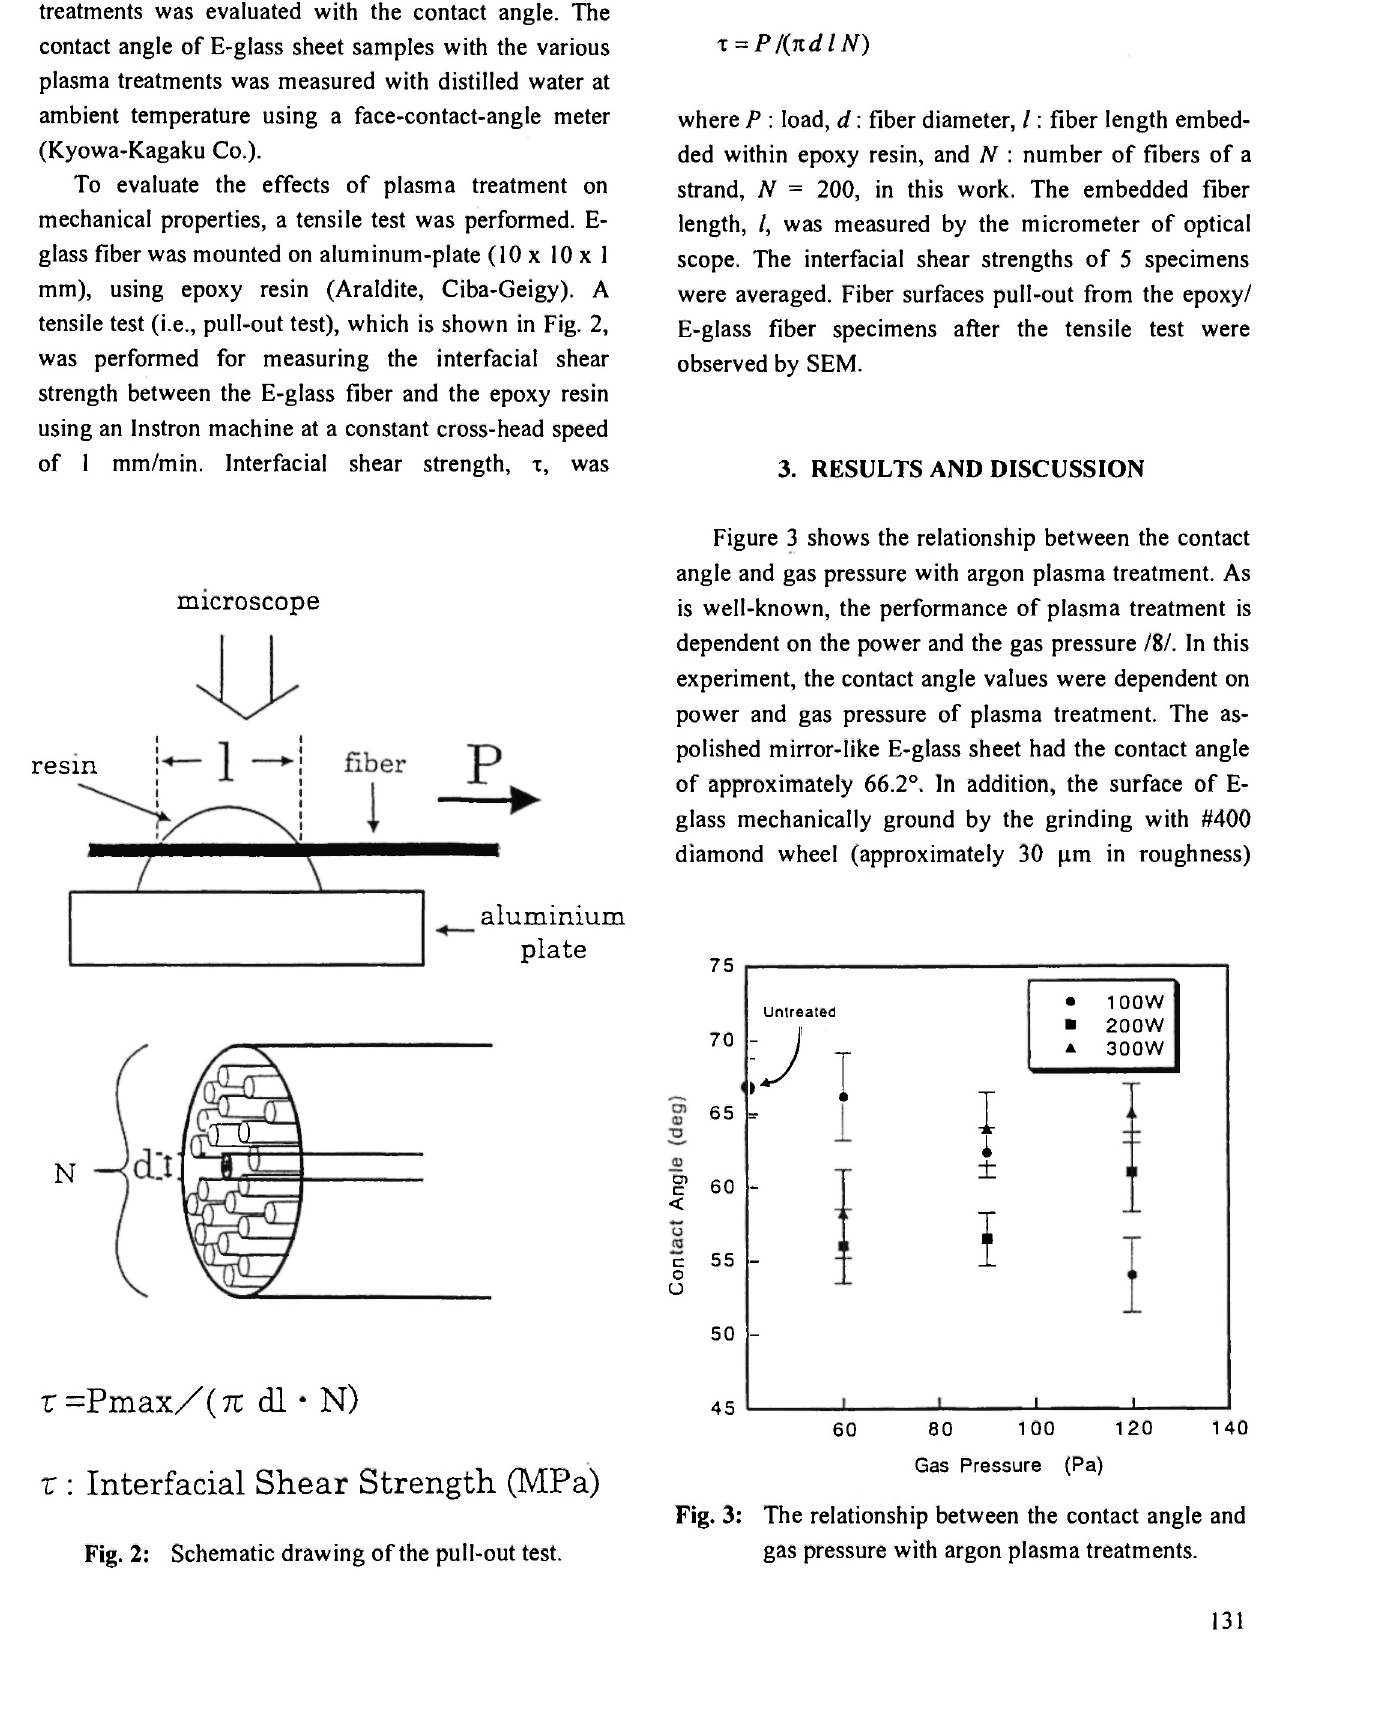
Fig. 2: Schematic drawing of the pull-out test.